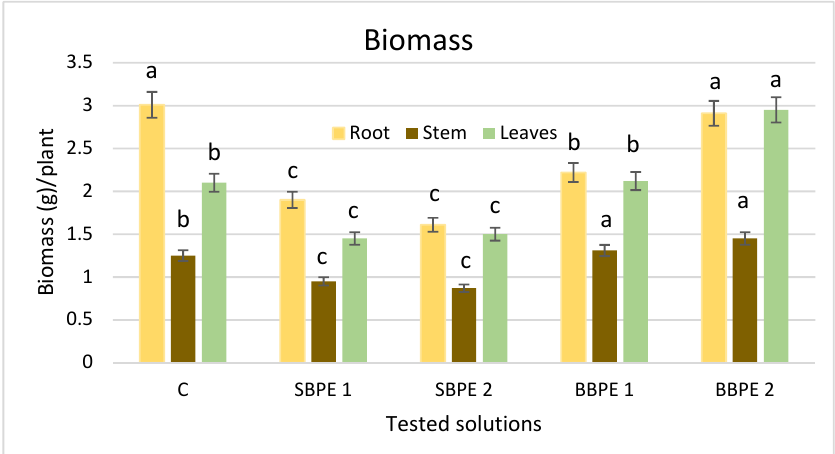
Figure 2. Influence of bark extracts on biomass accumulation in lemon balm (Different letters indicate significant differences, p ≤ 0.05. Error bars represent the standard deviation of means. C—control. SBPE 1—spruce bark polyphenolic extract at a concentration of 0.25 g bark/100 mL water. SBPE 2—spruce bark polyphenolic extract at a concentration of 0.5 g bark/100 mL water. BBPE 1—beech bark polyphenolic extract at a concentration of 0.25 g bark/100 mL water. BBPE 2—beech bark polyphenolic extract at a concentration of 0.5 g bark/100 mL water.